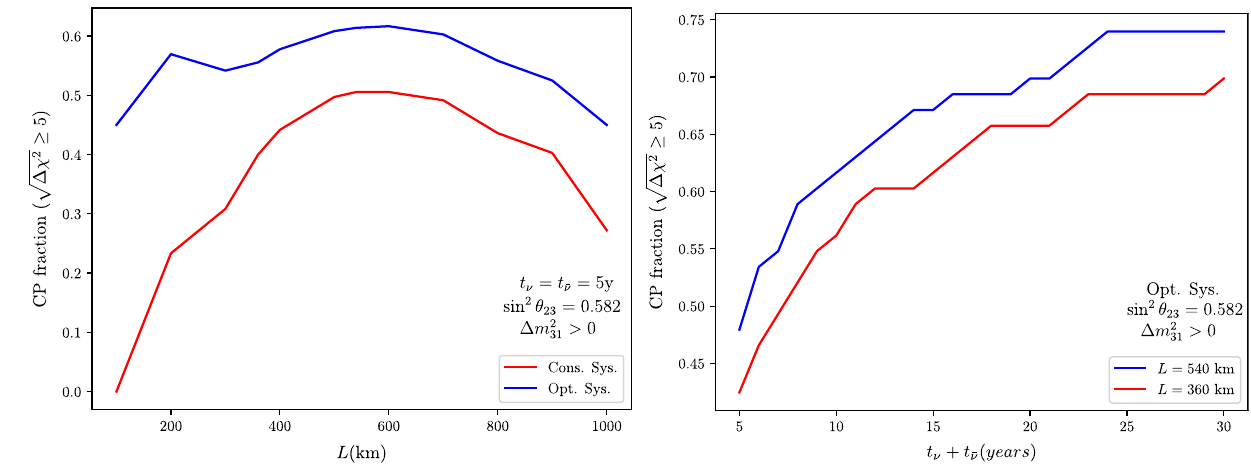
Fig. 11 Fractionofvaluesof δ forwhichCPviolationcouldbediscov- ered above 5 σ for different baselines to the far detector (left panel) for the two different sets of systematics from Table 1. In the right panel we show the CP fraction for the Garpenberg ( L = 540 km) and Zinkgru-